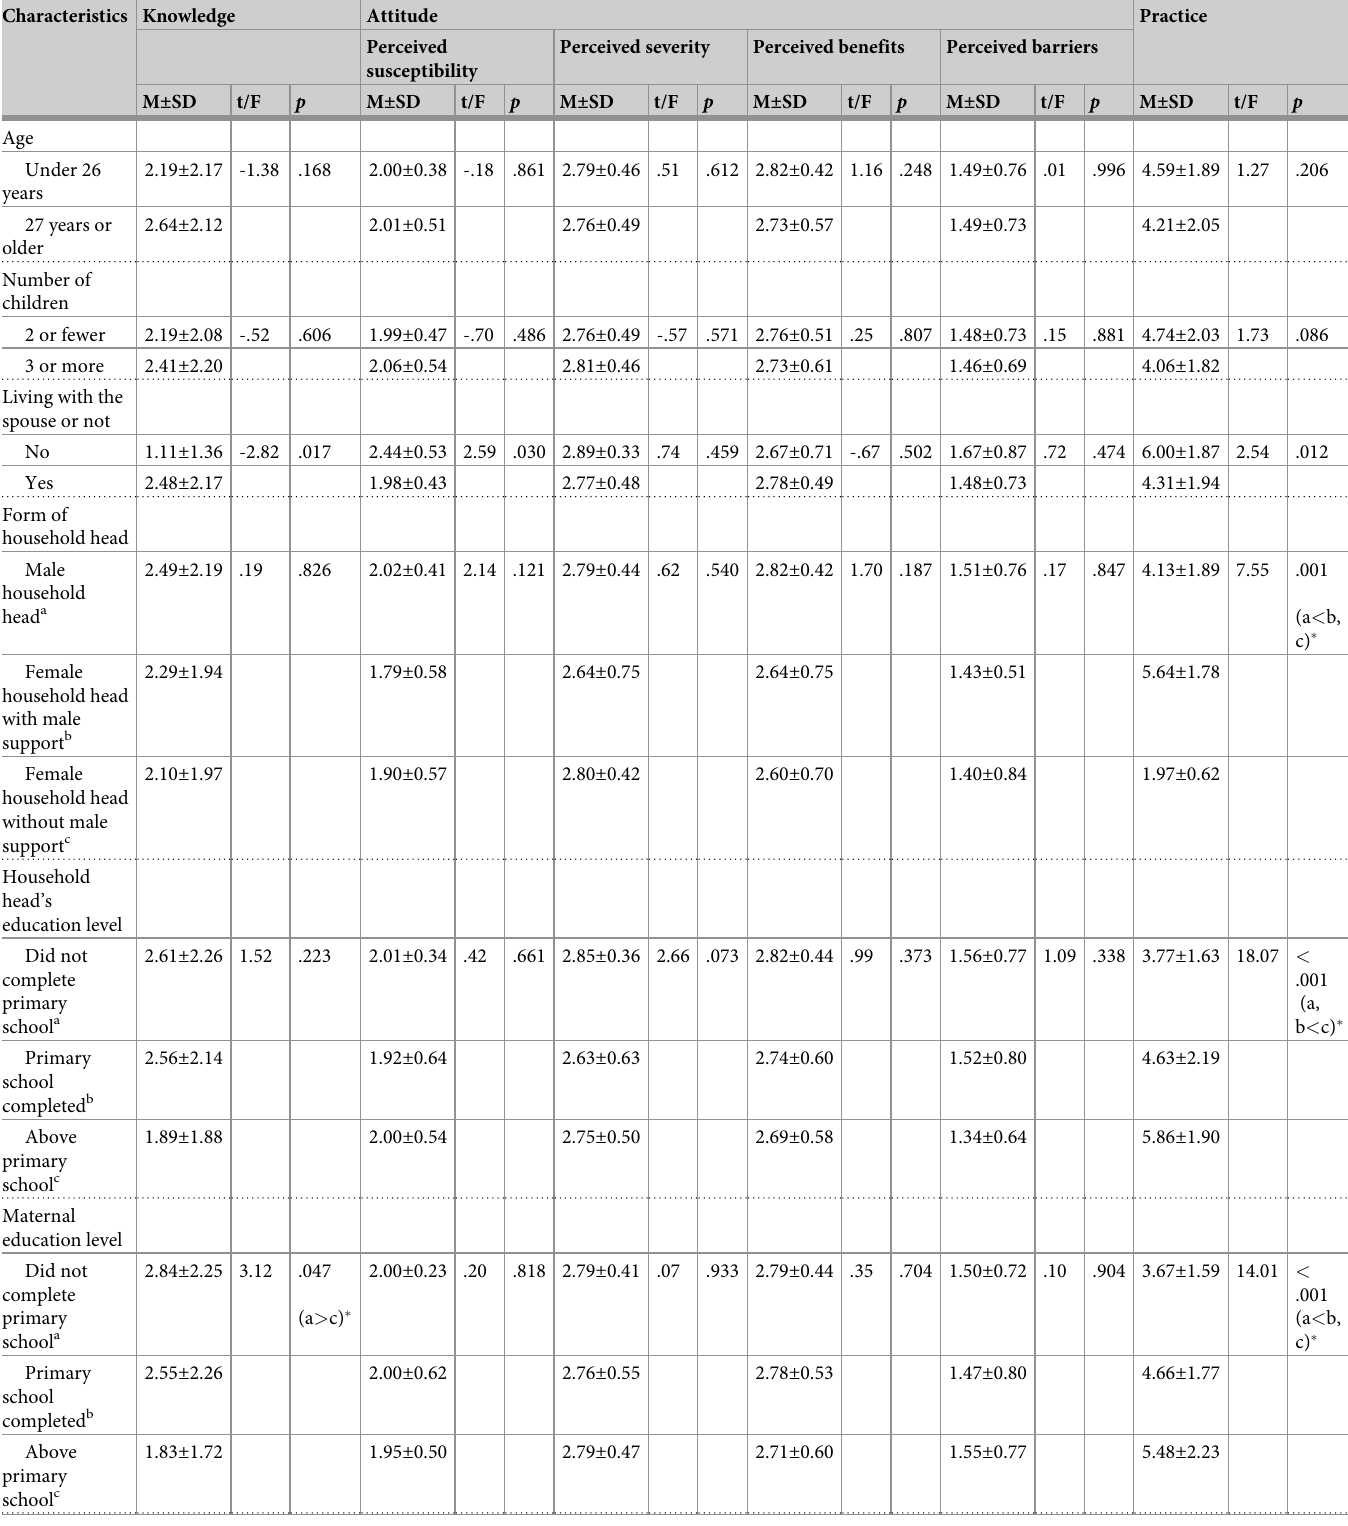
Table 3. Nutritional knowledge, attitudes, and practices according to general